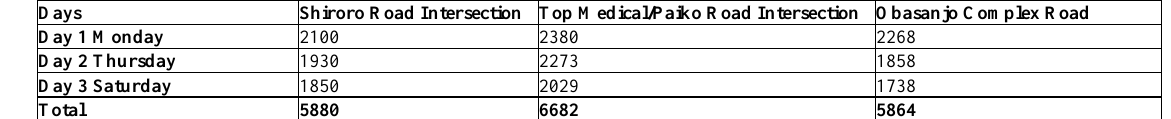
Table 7. Comprehensive Report Showing the Number of Violators at the three major Traffic Points from Survey Locations. Source: Medayese et al., 2016